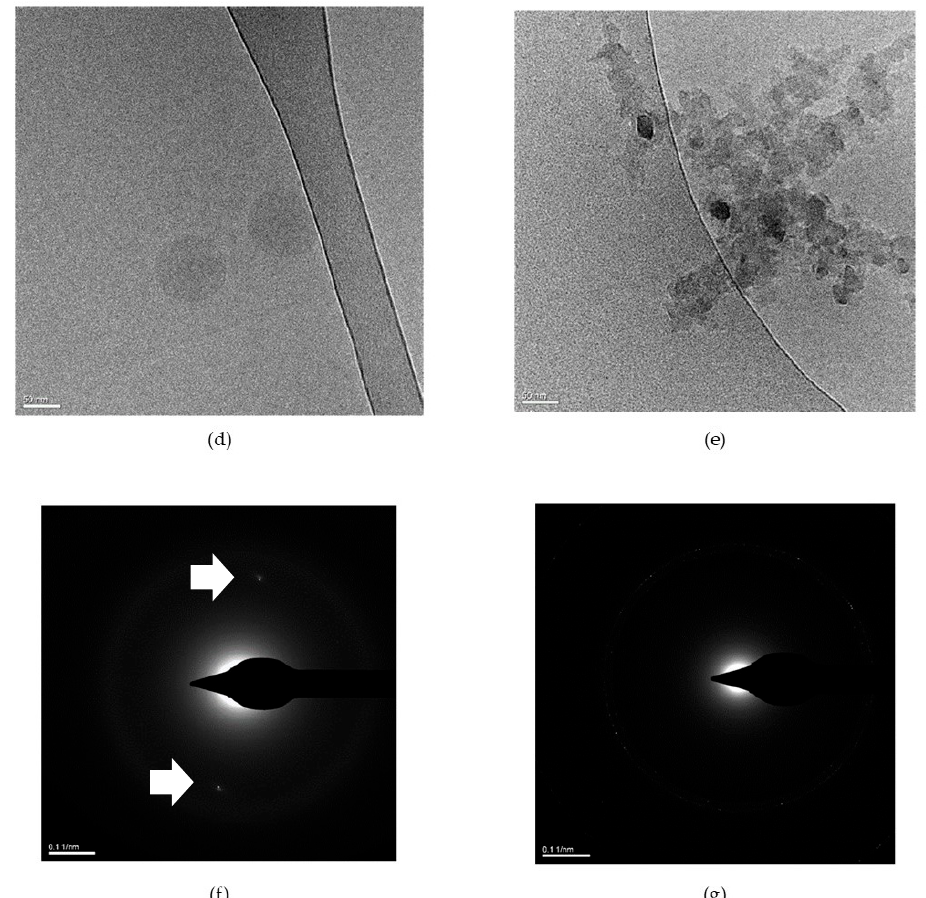
Figure 2. pH-Responsiveness of the mixed micelles. ( a ) The particle sizes of the TPH and TPM mixed micelles were measured by DLS in pH 4.0 condition after incubation at 37 °C for 6 and 24 h. ( b ) The micelles were measured by DLS in pH 4.0 condition after incubation at 37 ◦ C for 6 and 24 h. ( b ) The CD spectrum of micelles were conducted to determine their secondary structures. ( c ) XRD patterns of the TPH and TPM mixed micelles after acidic treatment for 24 h. A cryoTEM was utilized for morphological observation of TPM micelles after incubation at pH 7.4 ( d ) and 4.0 ( e ) for 24 h. The diffraction images of TPM mixed micelles at pH 7.4 ( f ) and pH 4.0 ( g ) were simultaneous undergone